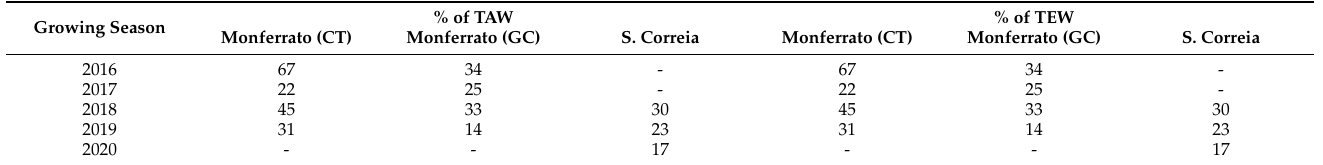
Table 3. Initial soil water contents in the root zone (% of TAW) and evaporable soil layer (% of TEW) in each case study and growing